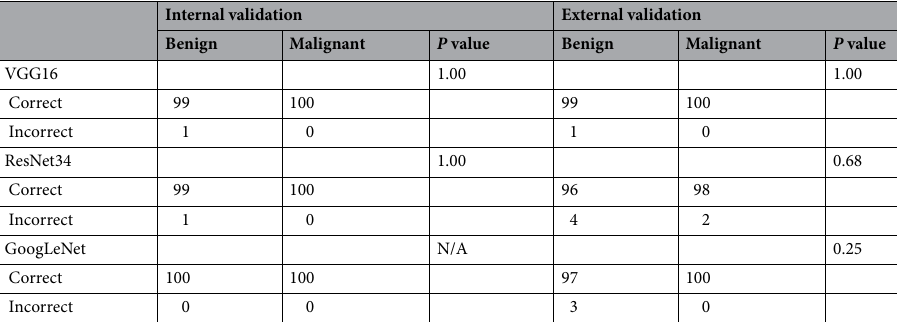
Table 4. Metrics for discriminative localization of benign and malignant breast masses in the weakly- supervised deep learning algorithm. N/A = not applicable. For discriminative localization, we created binary images by applying a threshold of 0.3 to a class activation map (CAM) and compared them with manual annotation. Discriminative localization is regarded as correct when the segmented area overlaps with the manually annotated